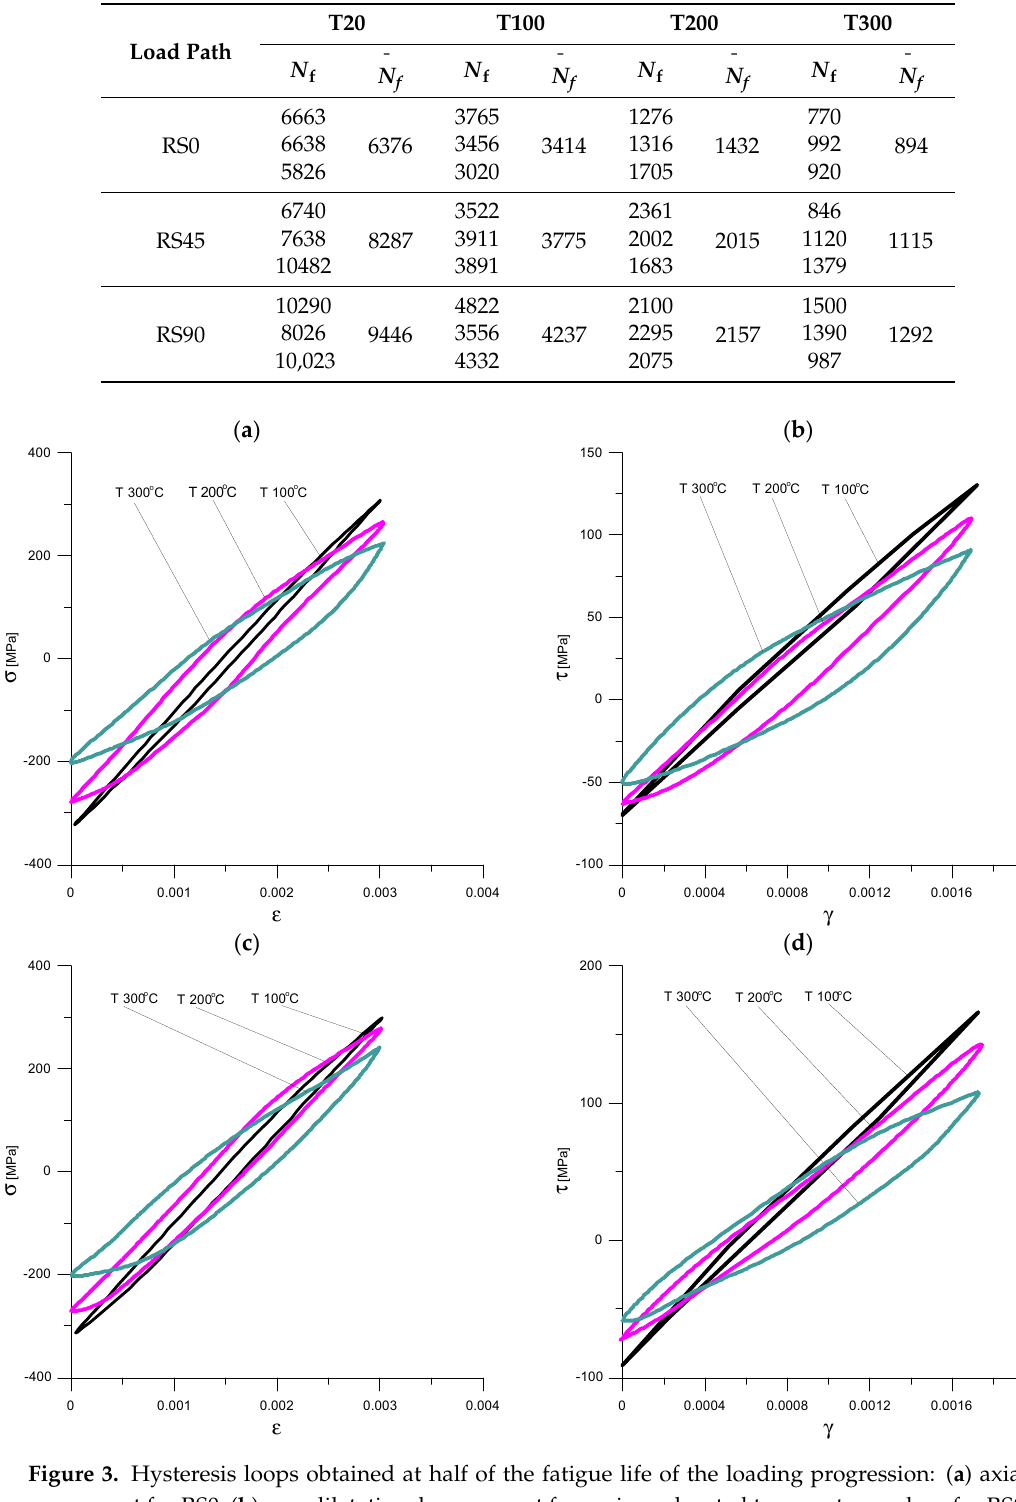
Table 4. Results of experimental fatigue life tests for multiaxial loading configurations (tension/compression with torsion).